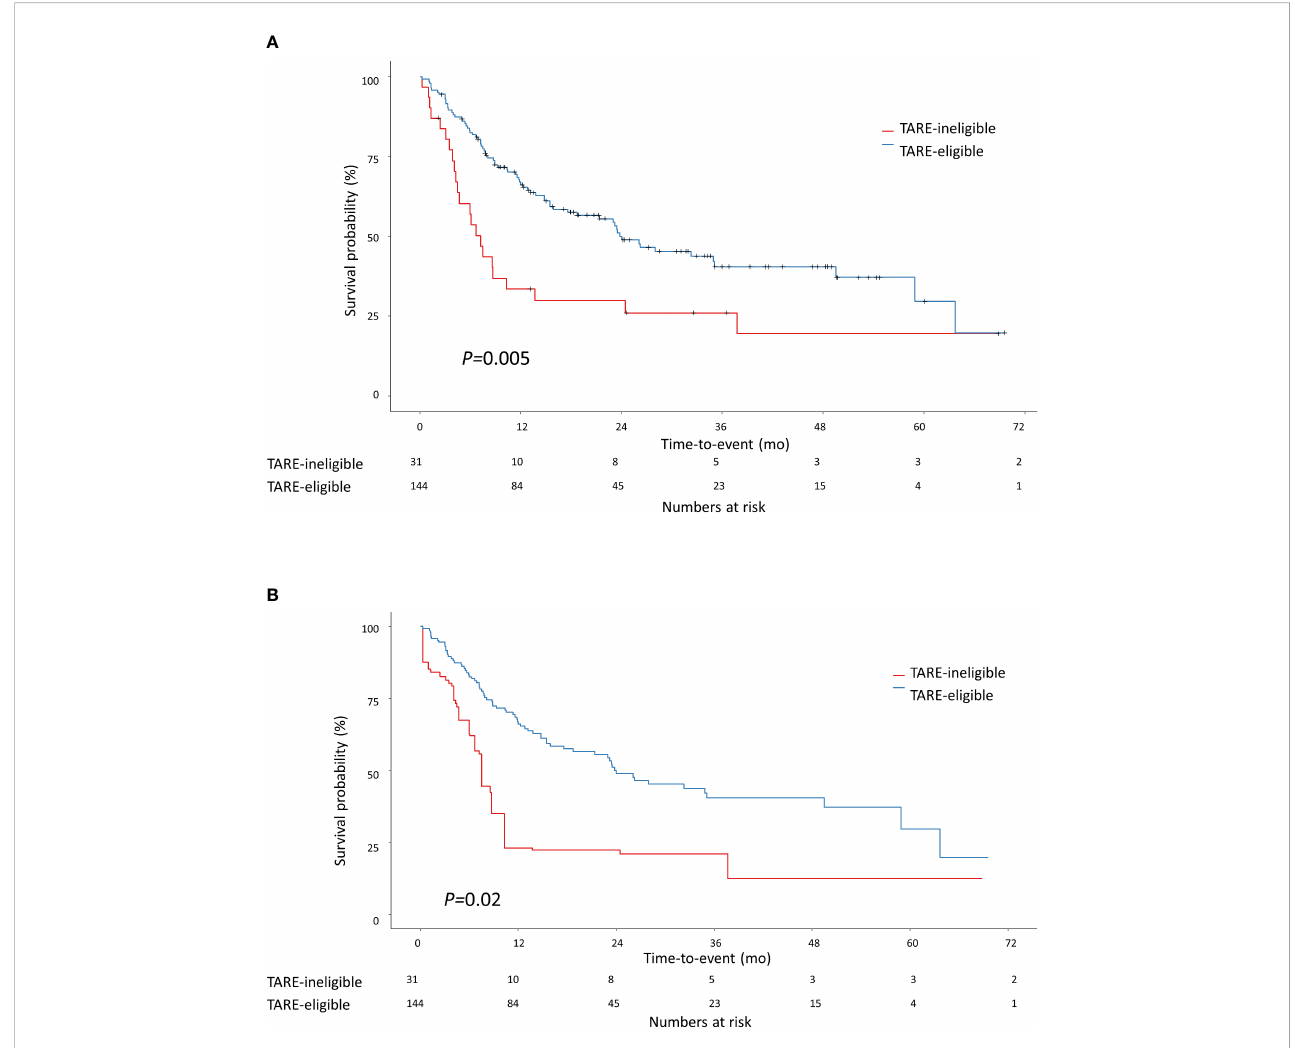
FIGURE 2 Kaplan-Meier methodology was used to estimate time-to-progression between TARE-eligible and TARE-ineligible groups (A) before applying IPTW and (B) after applying IPTW. Propensity score for IPTW were computed using the following variables: tumor size, MoRAL score, Child-Pugh class, and BCLC stage. BCLC, Barcelona Clinic Liver Cancer; IPTW, inverse probability of treatment weighting; MoRAL, model to predict tumor recurrence after living donor